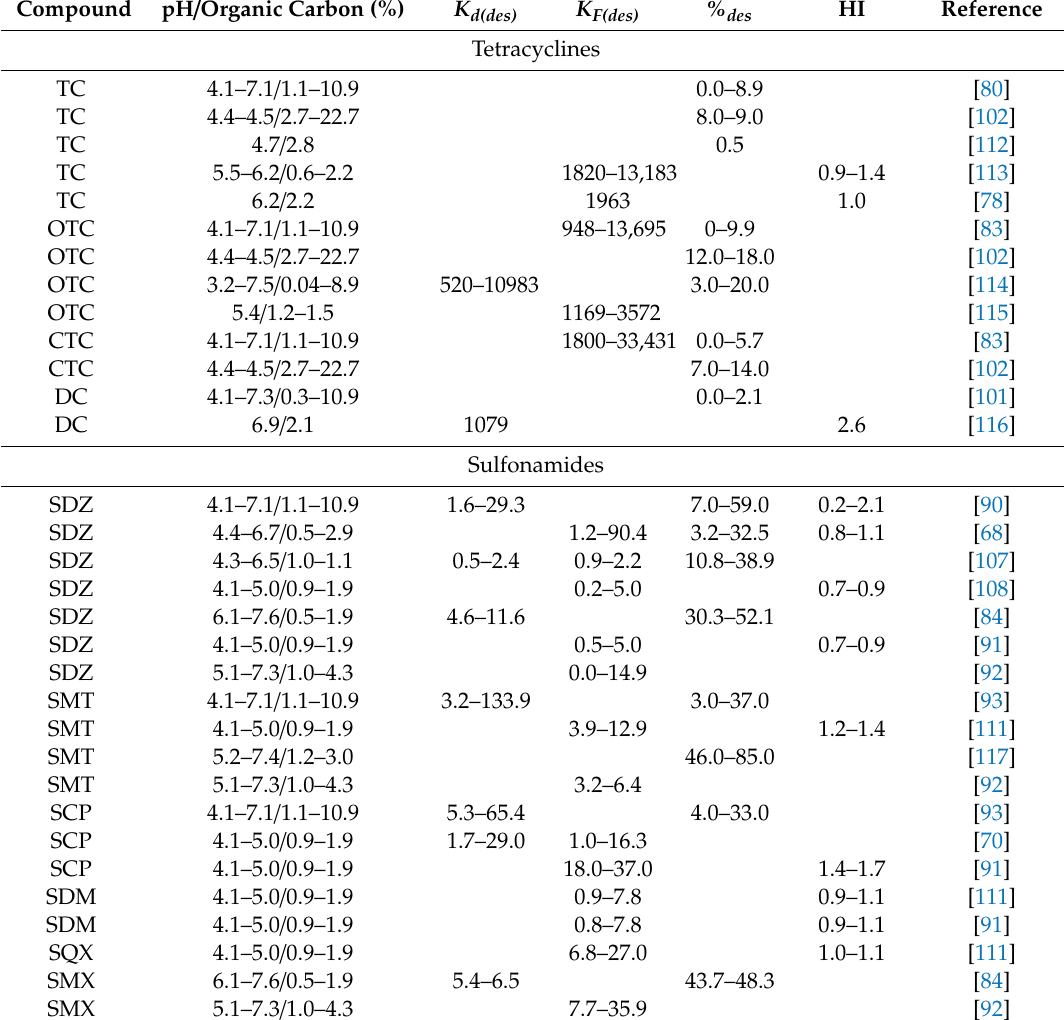
Table 8. Values for desorption parameters corresponding to various tetracycline and sulfonamide antibiotics in di ff erent soils. K d(des) (L kg − 1 ): coe ffi cient of distribution for desorption; K